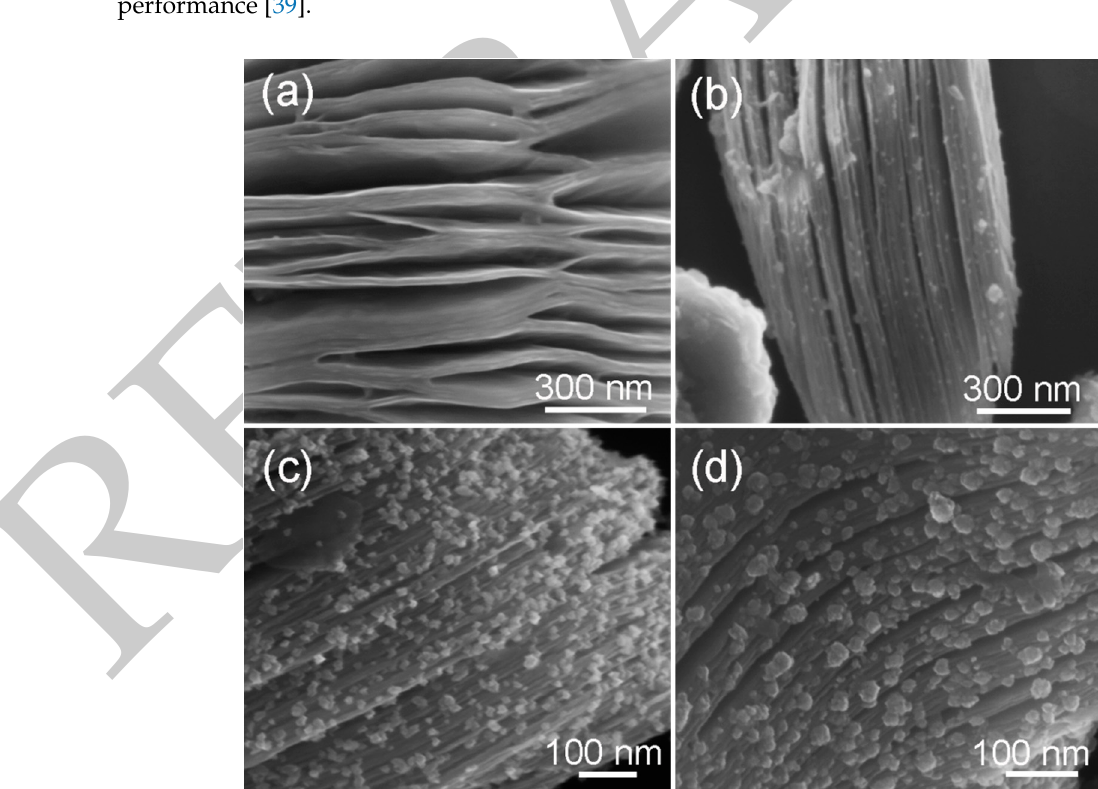
/ TiN / Ti 3 C 2 T x